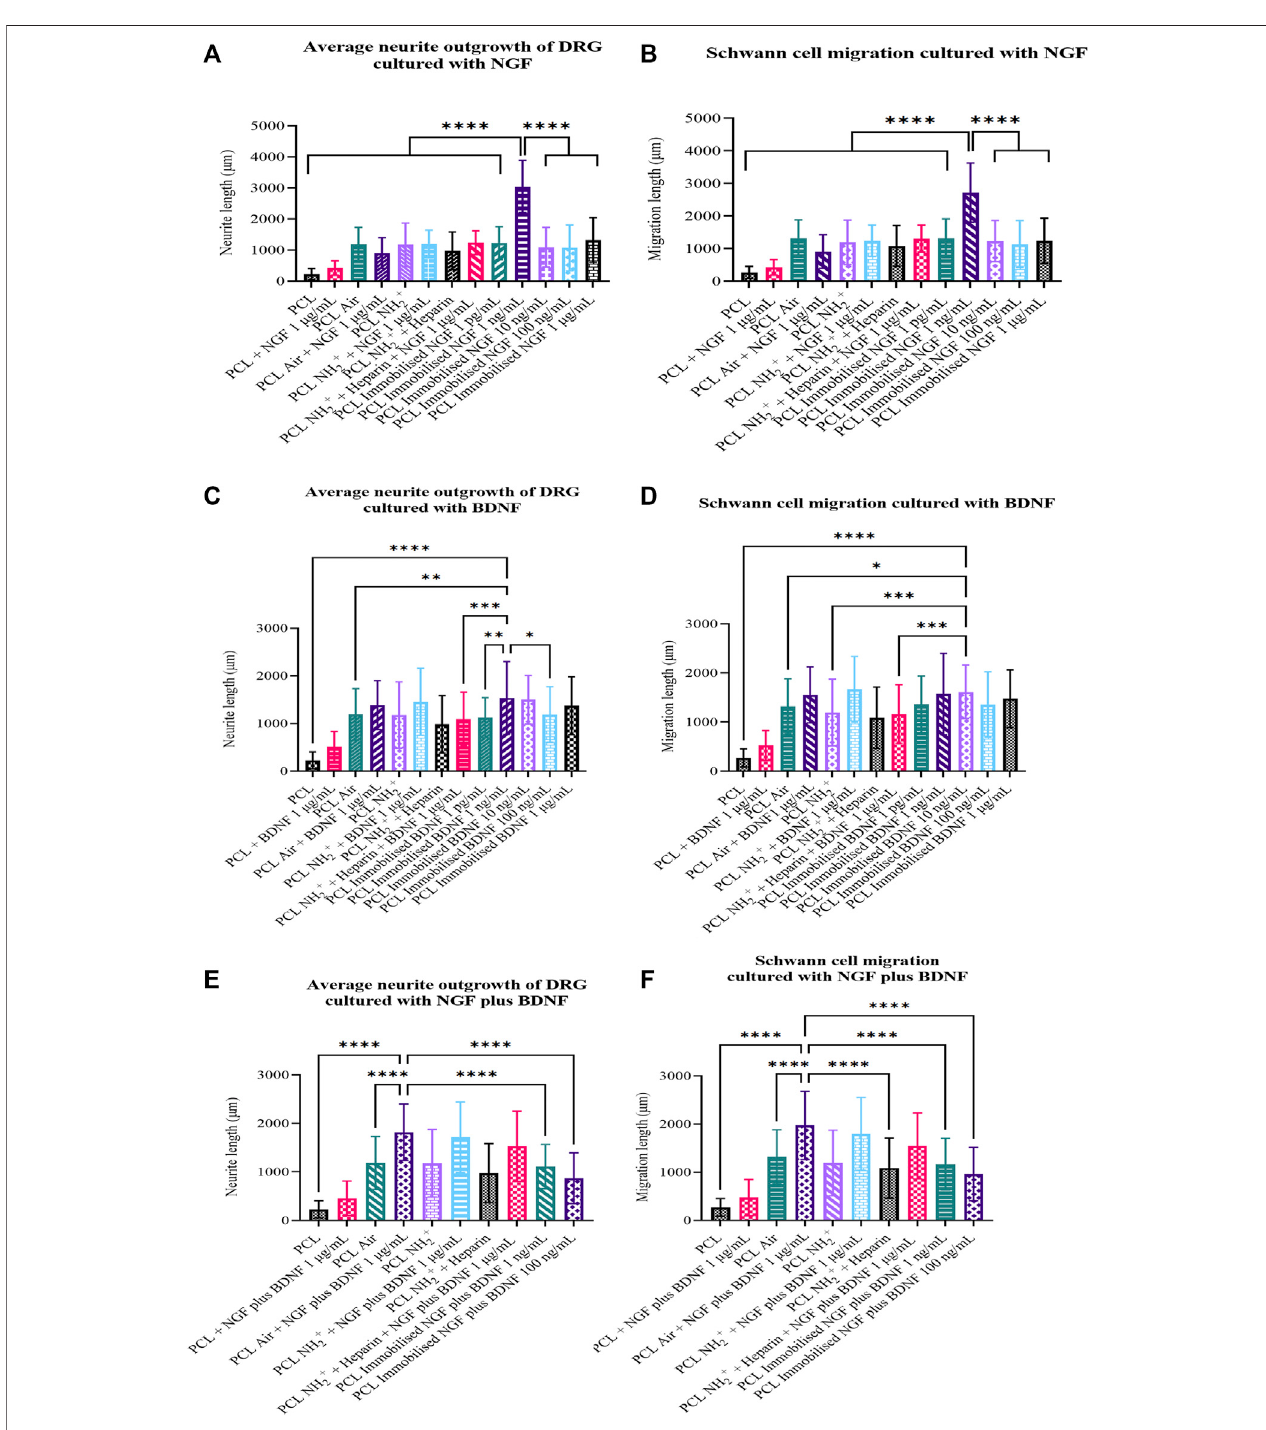
FIGURE 4 | Average neurite length and Schwann cell migration of DRG when cultured on PCL scaffolds, PCL Air scaffolds, PCL + NH 2+ scaffolds, PCL + NH 2+ + Heparin scaffolds, and PCL + NH 2+ + Heparin + Immobilised neurotrophin for 7 days. (A) Average neurite length and (B) Schwann cell migration for when DRG were cultured with NGF. NGF was immobilised on the bioactive surfaces at 1 pg/ml, 1 ng/ml, 10 ng/ml, 100 ng/ml, and 1 µg/ml. NGF was added in solution at 1 µg/ml with control surfaces. (C) Average neurite length and (D) Schwann cell migration for when DRG were cultured with BDNF. BDNF was immobilised on the bioactive surfaces at 1 pg/ml, 1 ng/ml, 10 ng/ml, 100 ng/ml, and 1 µg/ml. BDNF was added in solution at 1 µg/ml with control surfaces. (E) Average neurite length and (F) Schwann cell migration for when DRG were cultured with NGF plus BDNF. NGF plus BDNF were immobilised on the bioactive surfaces at 1 and 100 ng/ml. NGF plus BDNF were added in solution at 1 µg/ml with control surfaces. One-way ANOVA statistical analysis was performed with Tukey procedure of multiple comparisons * p < 0.05, ** p < 0.01, *** p < 0.001, **** p < 0.0001.